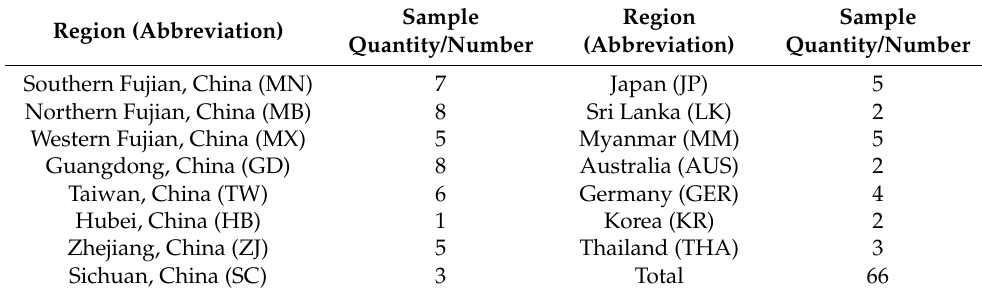
Table 1. Origin and quantity of Oolong tea